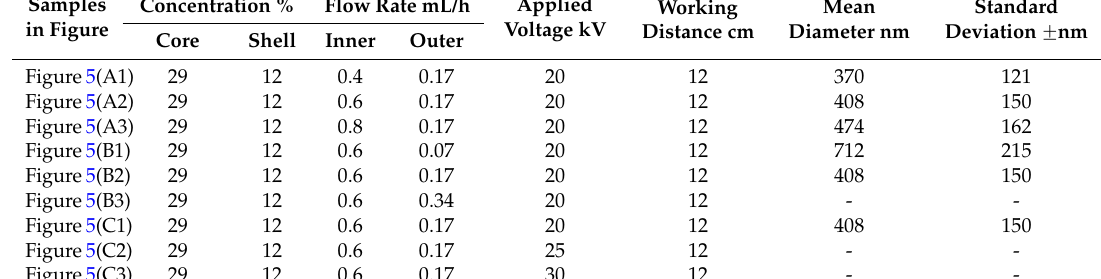
Table 2. Process parameters and statistical analysis of nanofiber diameters obtained from the FE-SEM images (sample size N = 100).